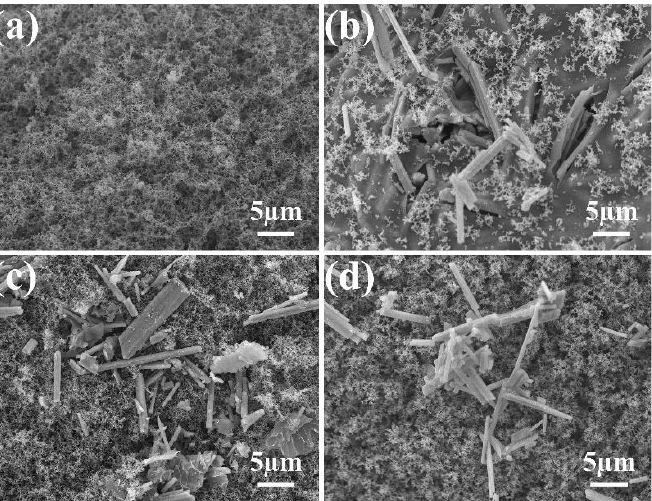
Figure 13. SEM images of char residues for EP ( a ), EP/7.5MBR@LDHP-APES ( b ), EP/7.5MBR@LDHP ( c ) and EP/7.5MBR ( d ).